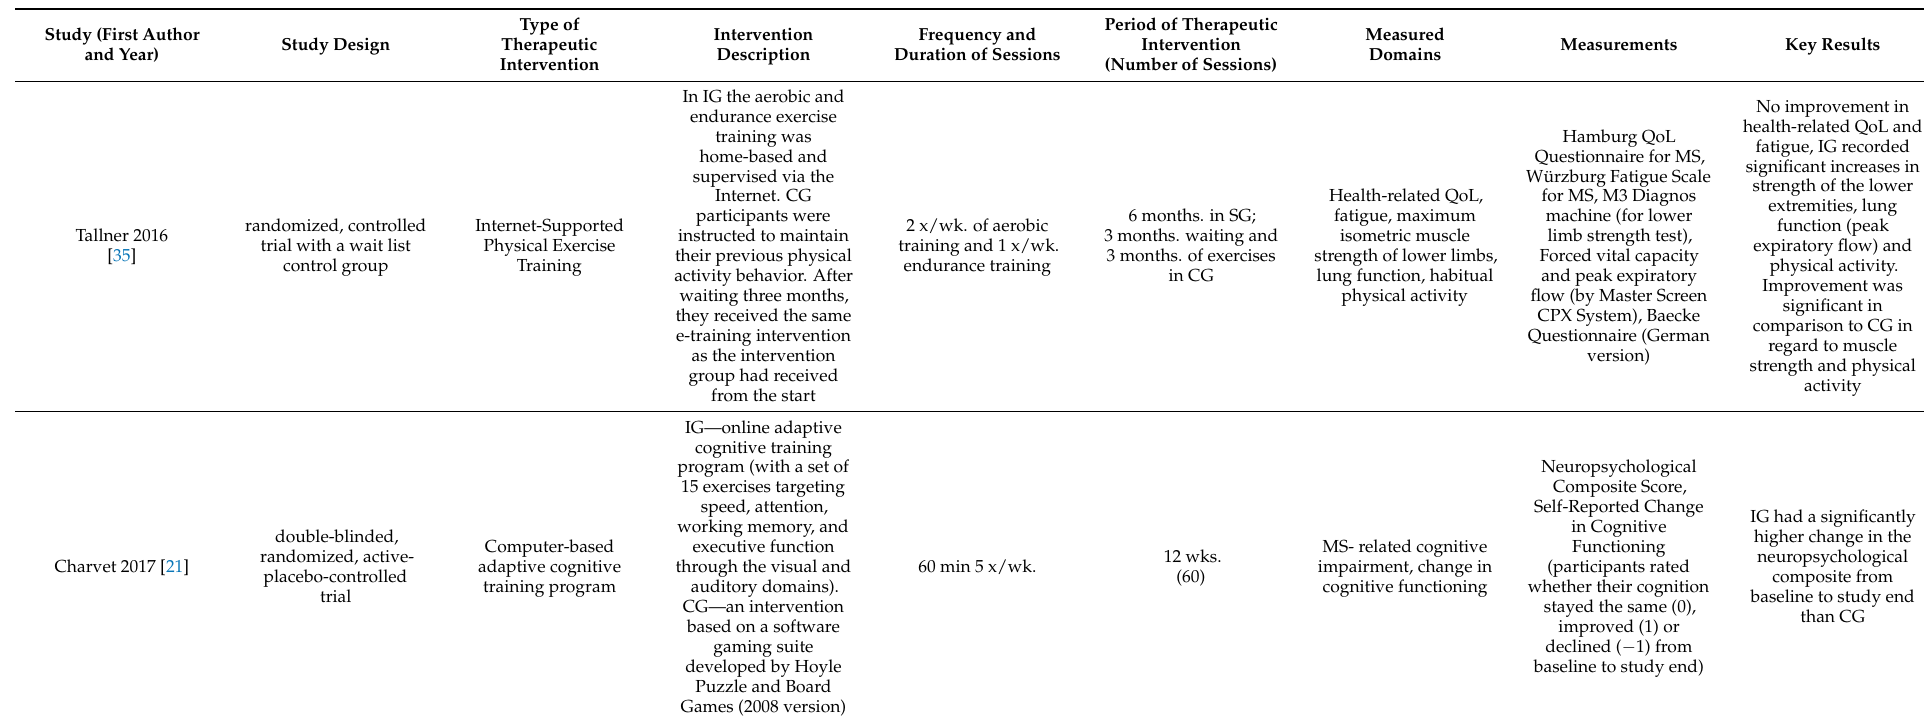
Table 7. Characteristics of studies analyzing the effect of new technologies and other health-related outcomes in MS